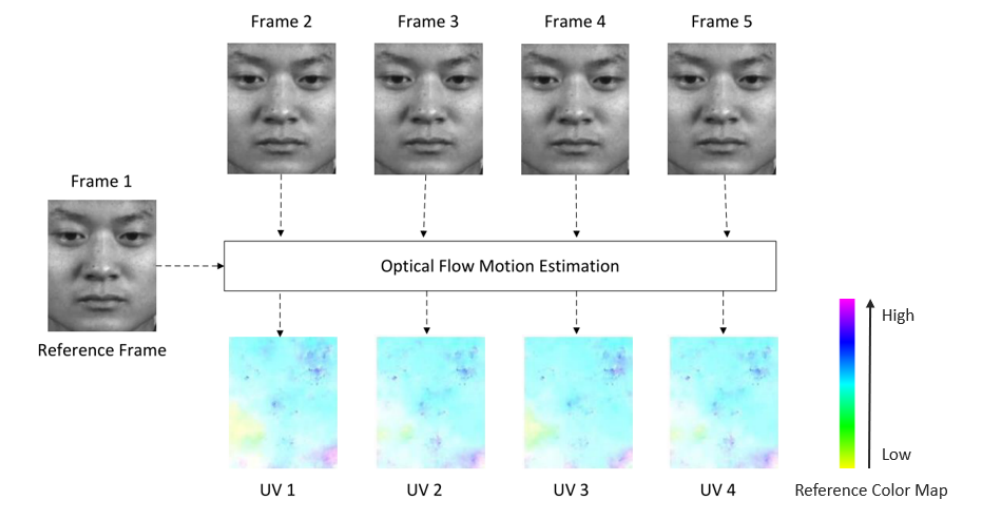
Figure 2. Example of optical flow motion estimation, where we set the first frame of ME image sequence as the reference frame and then compute the optical flow field between the reference frame and the rest of the frames with a subspace trajectory